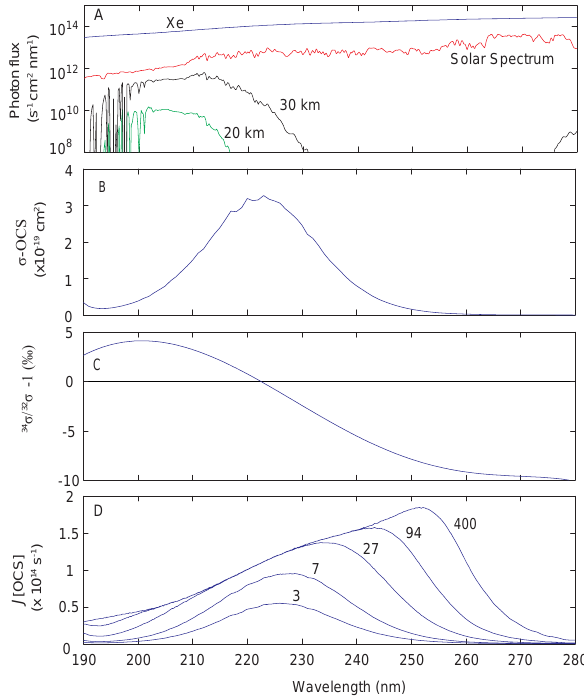
Fig. 2. Input parameters for the models for isotope fractionation. (A) Comparison of photon flux of Xe arc lamp and solar spec- trum (Rottman et al., 2006). (B) OCS cross section from Molina et al. (1981). (C) 34 σ / 32 σ -1 estimated from ZPE-shift method. (D) Photolysis rate as a function of OCS pressure (numbers in diagram in mbar). Actinic flux at different altitudes is calculated similarly to Farquhar et al. (2001) for a solar zenith angle of 30 ◦ . Xe lamp used in this study has higher photon flux compared to solar spectrum by about a factor of 20 for the region between 190 and